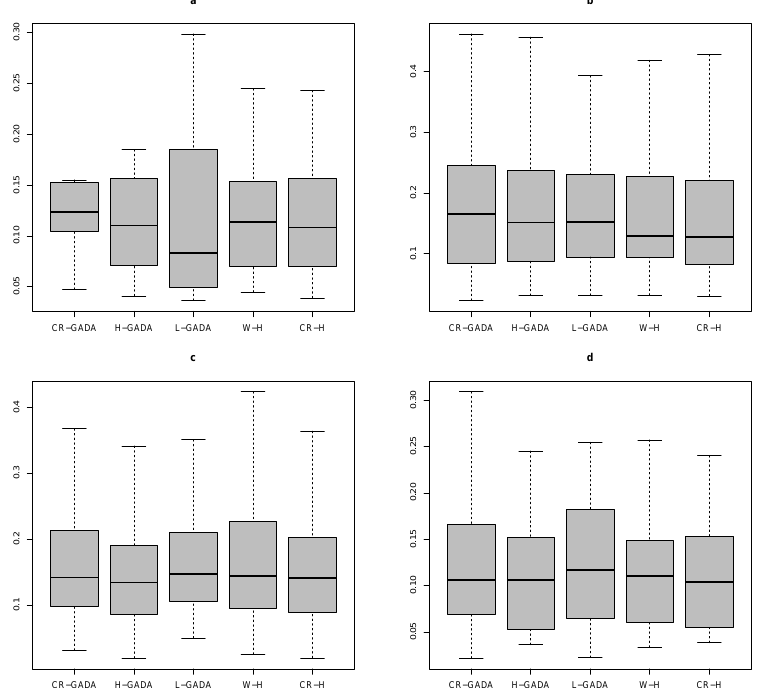
Figure 4. Boxplot (including the minimum score, first (lower) quartile, median, third (upper) quartile, and maximum score) of the Mean Absolute Percentage Error (MAPE) function calculated for the species: ( a ) Pinus arizonica , ( b ) Pinus engelmannii , ( c ) Pinus strobiformis and ( d ) Pinus teocote , for the GADA and W-H models in comparison with the CR-H model proposed in the